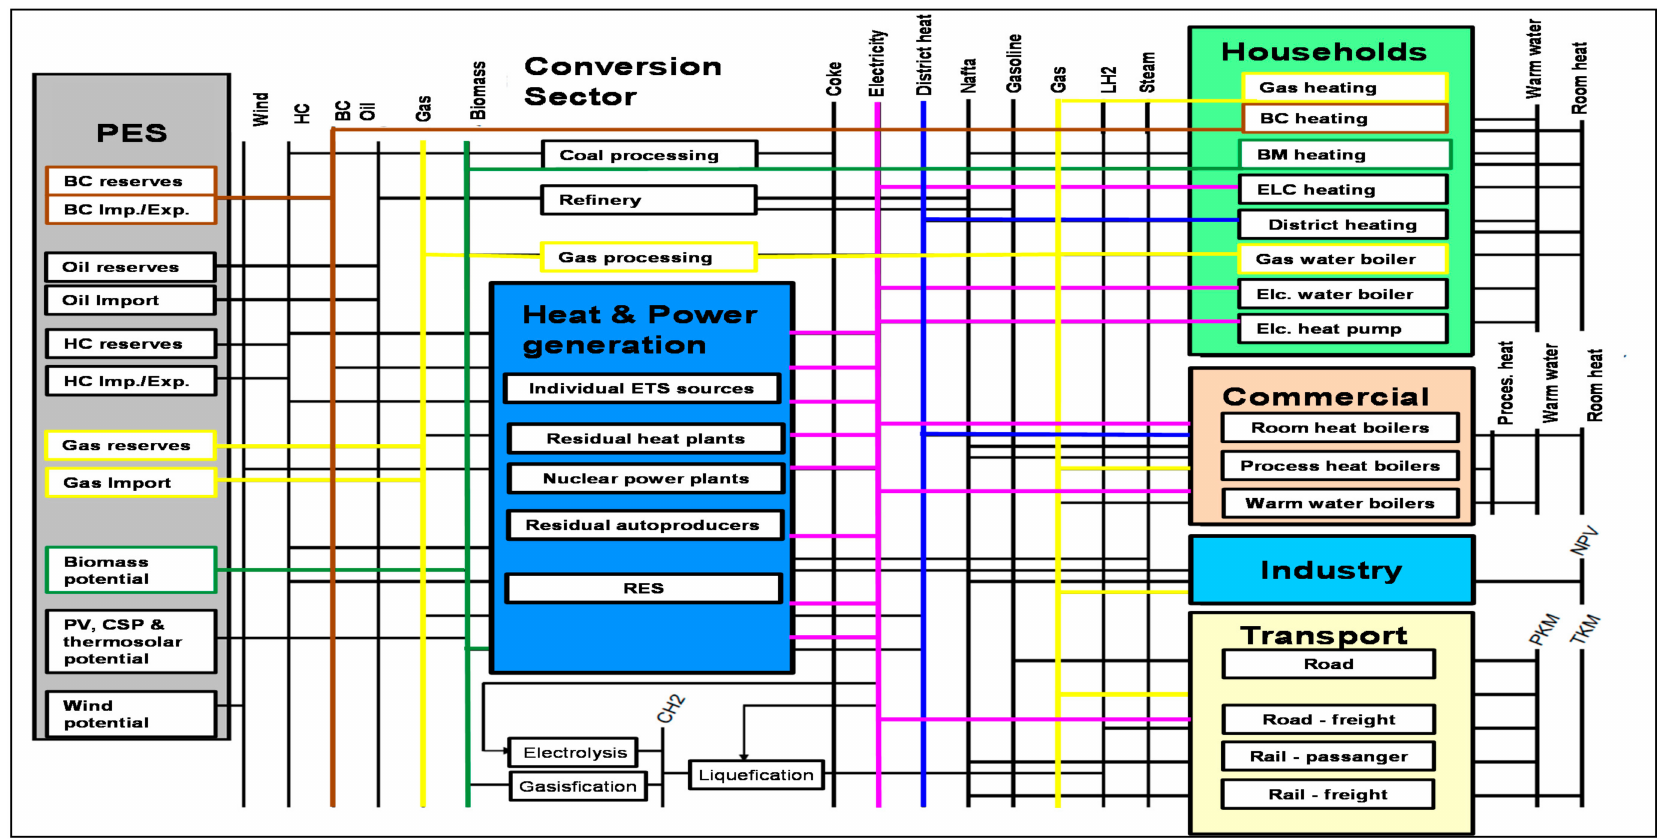
Figure A1. Model TIMES-CZ schematic structure. Note: PES—primary energy sources, BC—brown coal, Imp./Exp.—Import/Export, HC—hard coal, PV—photovoltaic, CSP—concentrated solar power, ETS—emission trading system, RES—renewable energy sources, CH2—compressed hydrogen, LH2—liquid hydrogen, BM—biomass, ELC—electrical, NPV—net present value, PKM—passenger-kilometre,